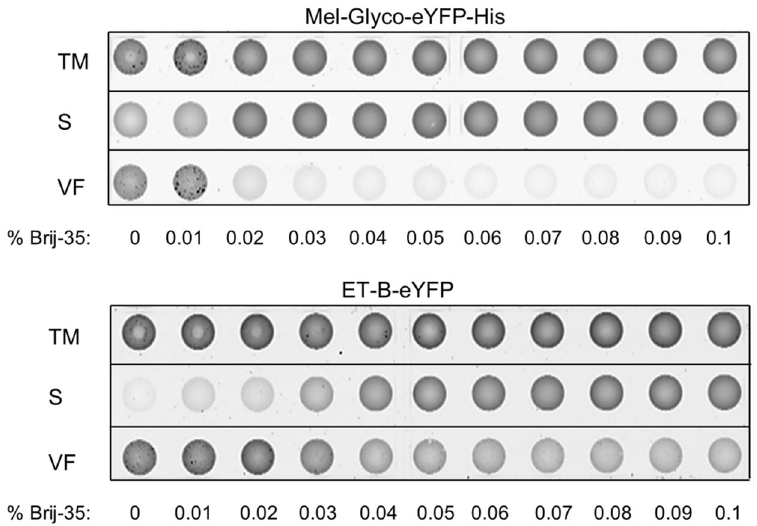
Figure 2. Localization of cell-free synthesized secreted and transmembrane proteins. Upper panel: The localization of the secreted protein Mel-Glyco-eYFP-His was determined by fluorescence analysis in the presence of defined Brij35 concentrations. The amount of Mel-Glyco-eYFP in the supernatant fraction indicates the state of perforation of microsomal membranes. Lower panel Fluorescence analysis of the localization of the transmembrane protein ET-B-eYFP in the presence of defined Brij35 concentrations. By applying higher Brij35 concentrations, the transmembrane protein ET-B-eYFP is slowly transferred into the